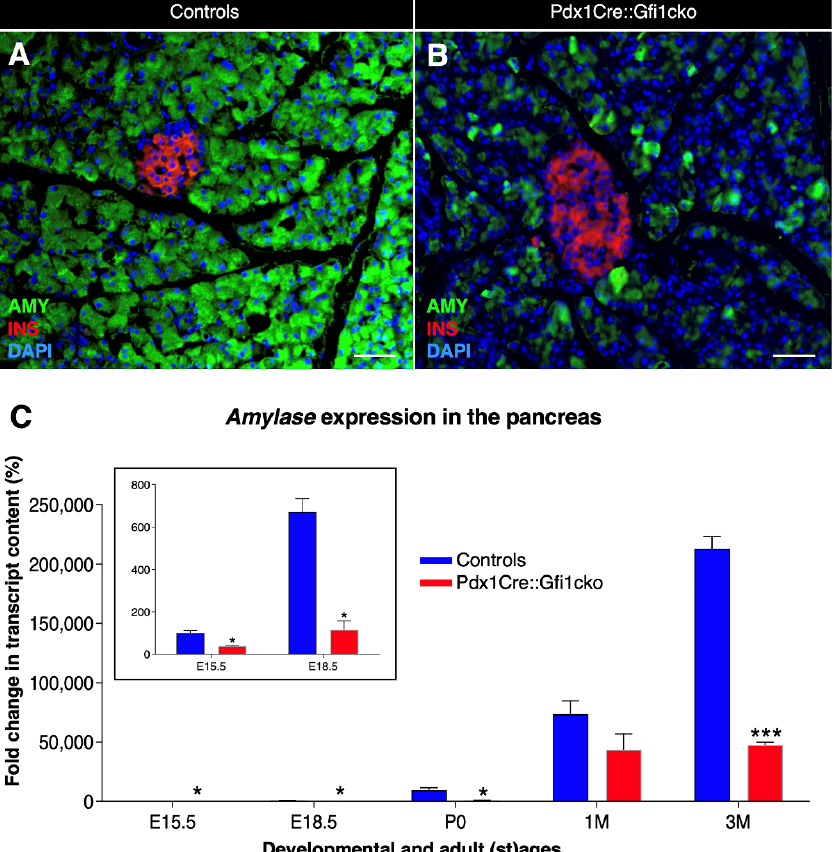
Figure 3. Important decrease in amylase expression in Pdx1Cre::Gfi1cko animals. Immunohistochemical analyses of Pdx1Cre::Gfi1cko and control mice using antibodies recognizing insulin (red) amylase (green) and DAPI (blue). Objective magnification: 20×. Scale bar: 50 μ m ( A , B ). Amylase expression levels were assessed by RT-qPCR at different developmental and adult ages. Insert graph shows amylase expression at E15.5 and E18.5 of both Gfi1 -conditional knockouts and controls. ( n = 5 animals per genotype per (st) age) (* p < 0.05, *** p < 0.001) ( C